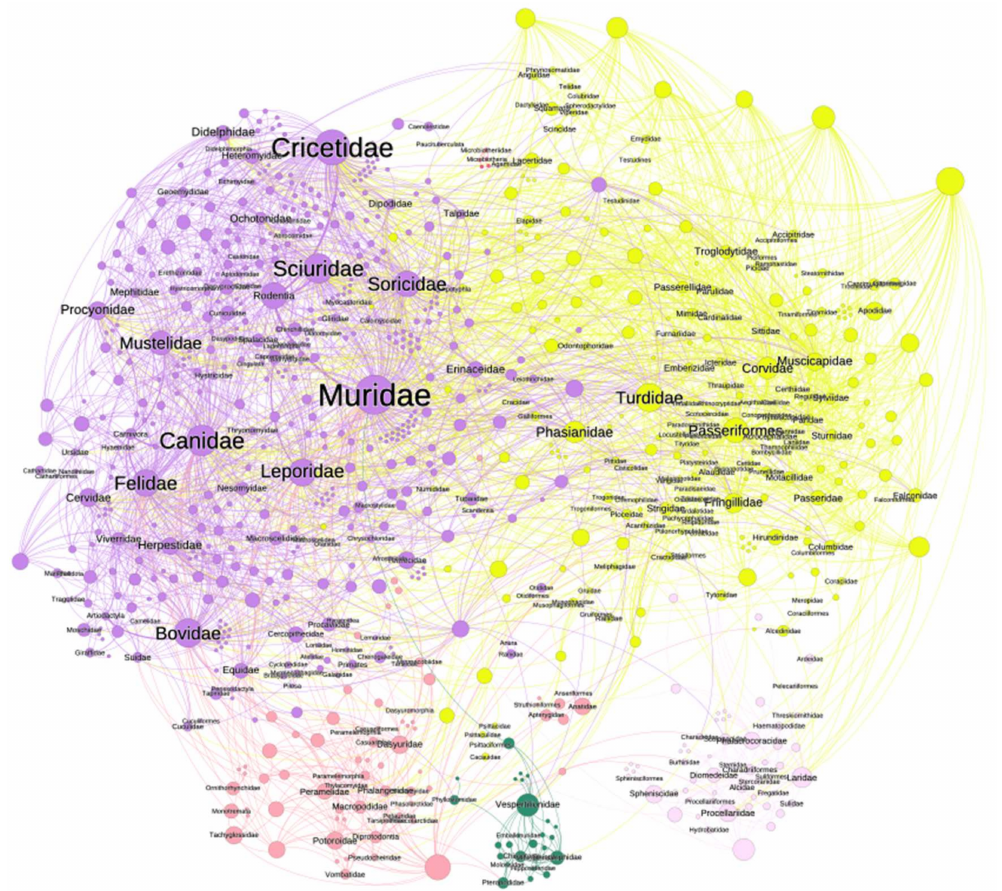
Figure 6. Tools to extract information on the circulation of TBP. Methods used for ecological studies could help to better capture the circulation of TBP. The network displayed shows the reported hosts of every species of the tick genus Ixodes in the world (compiled by Alberto A. Guglielmone, INTA, Rafaela, Argentina). Nodes (circles) are either species of ticks or families of vertebrates, and their size is proportional to their importance in the network; the labels of the tick species have been removed to improve the figure’s clarity. Lines (links) represent the use of a host by a tick. The colours correspond to clusters, groups of tick-vertebrates that tend to appear together more frequently than with others; this is a property of the network known as “modularity”. The complete network is available as Supplementary Material, allowing unlimited on-screen zoom. Such a network could be upgraded with links to pathogens circulated by combinations of vertebrates and ticks and with specific mention to the ecological region. Different indices can be obtained from a network, describing the importance of ecological interactions and co-occurrence events under different scales and abiotic